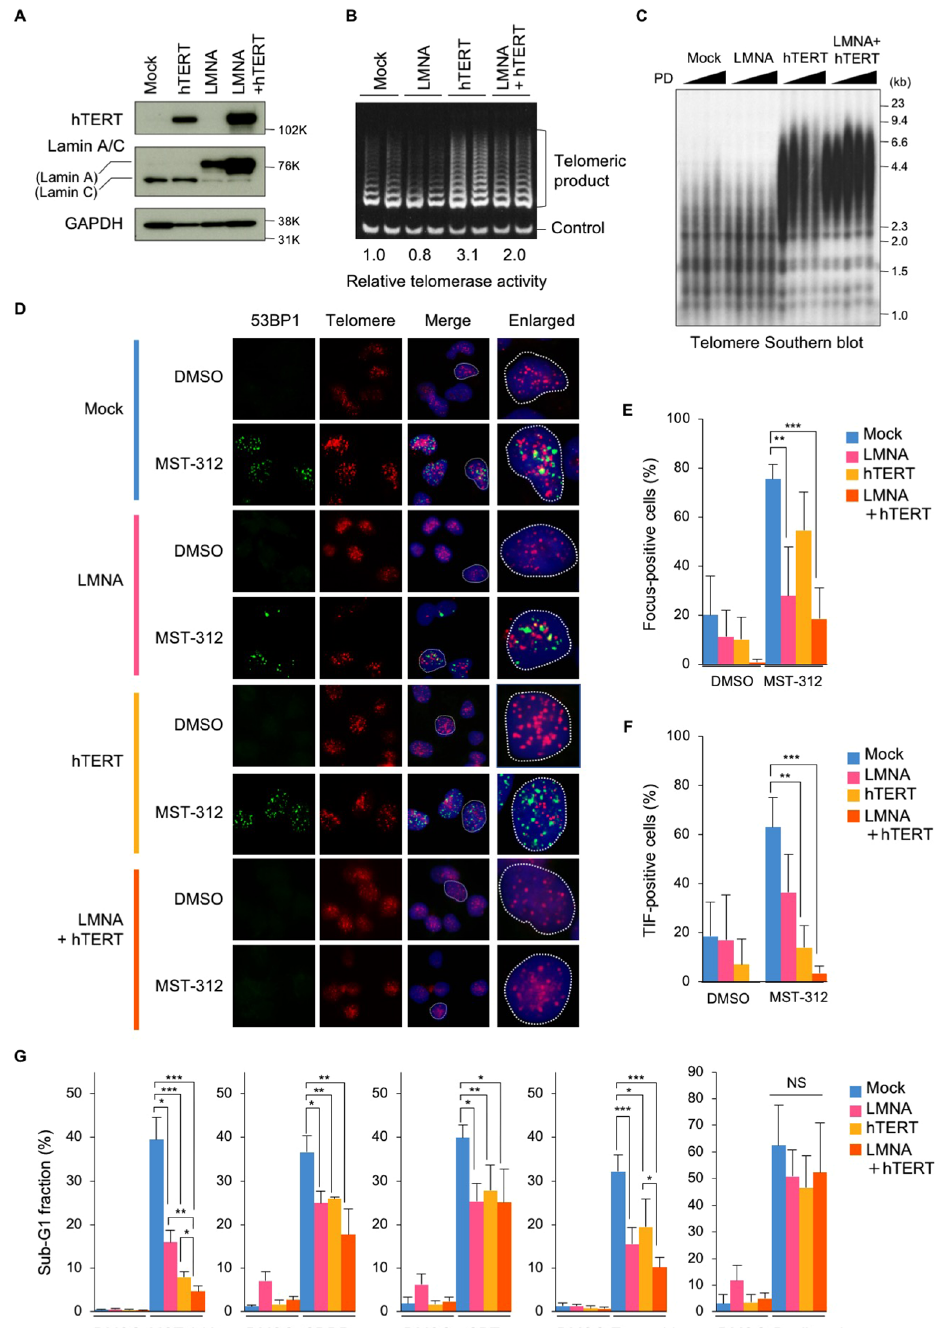
Figure 6. Telomere elongation and lamin A expression confers resistance to MST-312. ( A , B ) Telomere elongation and lamin A expression in NCI-H522 cells. Cells were infected with hTERT and/or LMNA expressing retrovirus. Cells were subjected to western blot analysis for detection of hTERT and lamin A expression ( A ) and TRAP assay for detection of telomerase activity ( B ). For ( A ) full-length blots were presented in Supplementary Fig. S5. ( C ) Telomere southern blot analysis. Genomic DNA was prepared and subjected to southern blot analysis with [ 32 P]-labelled telomeric probe. ( D ) Telomere immuno-FISH analysis. Cells were treated with 5 μ M MST-312 for 48 h and subjected to immuno-FISH analysis. Green : 53BP1; red : telomere DNA; blue : DAPI stain of DNA. ( E ) Quantitation of DNA damage foci in ( D ). Cells with more than four 53BP1 foci were counted as positive. ( F ) Quantitation of telomeric DNA damage (TIF and enlarged TIF) in ( D ). Cells with more than four TIF were counted as positive. ( G ) Apoptosis induced by MST-312 and anticancer drugs. Cells were treated with 5 μ M MST-312, 3.3 μ M cisplatin (CDDP), 10 nM camptothecin (CPT), 1.6 μ M etoposide or 5 nM paclitaxel for 96 h. Cells were stained with propidium iodide and the apoptotic sub-G1 fraction of the cell cycle was quantitated by flow cytometry. Error bar indicates standard deviation of four ( E , F ) or at least three ( G ) experiments. Statistical significance was evaluated by Tukey-Kramer test. * P < 0.05, ** P < 0.01, *** P < 0.001. NS: not